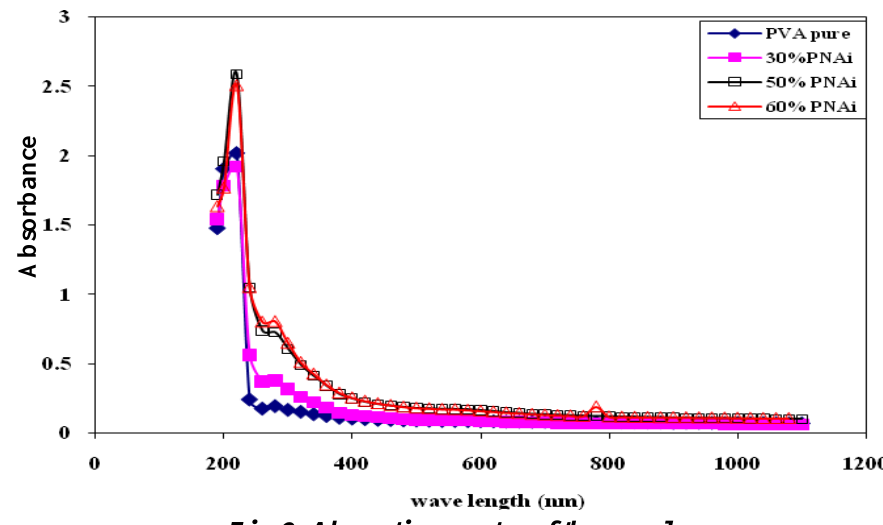
Fig. 2: Absorption spectra of the samples